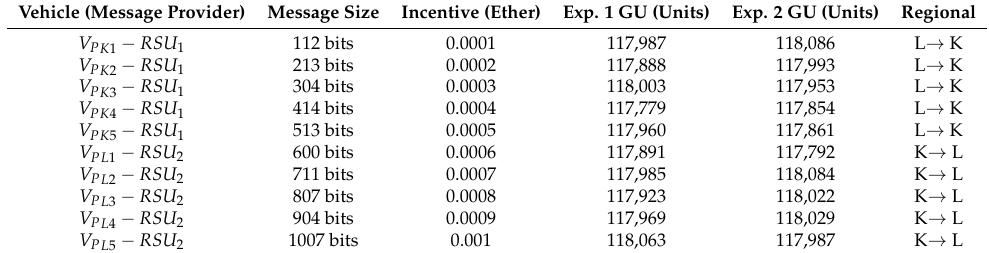
Table 4. Performance of the total gas usage and Ether distribution for the packet delivery ratio (PDR)